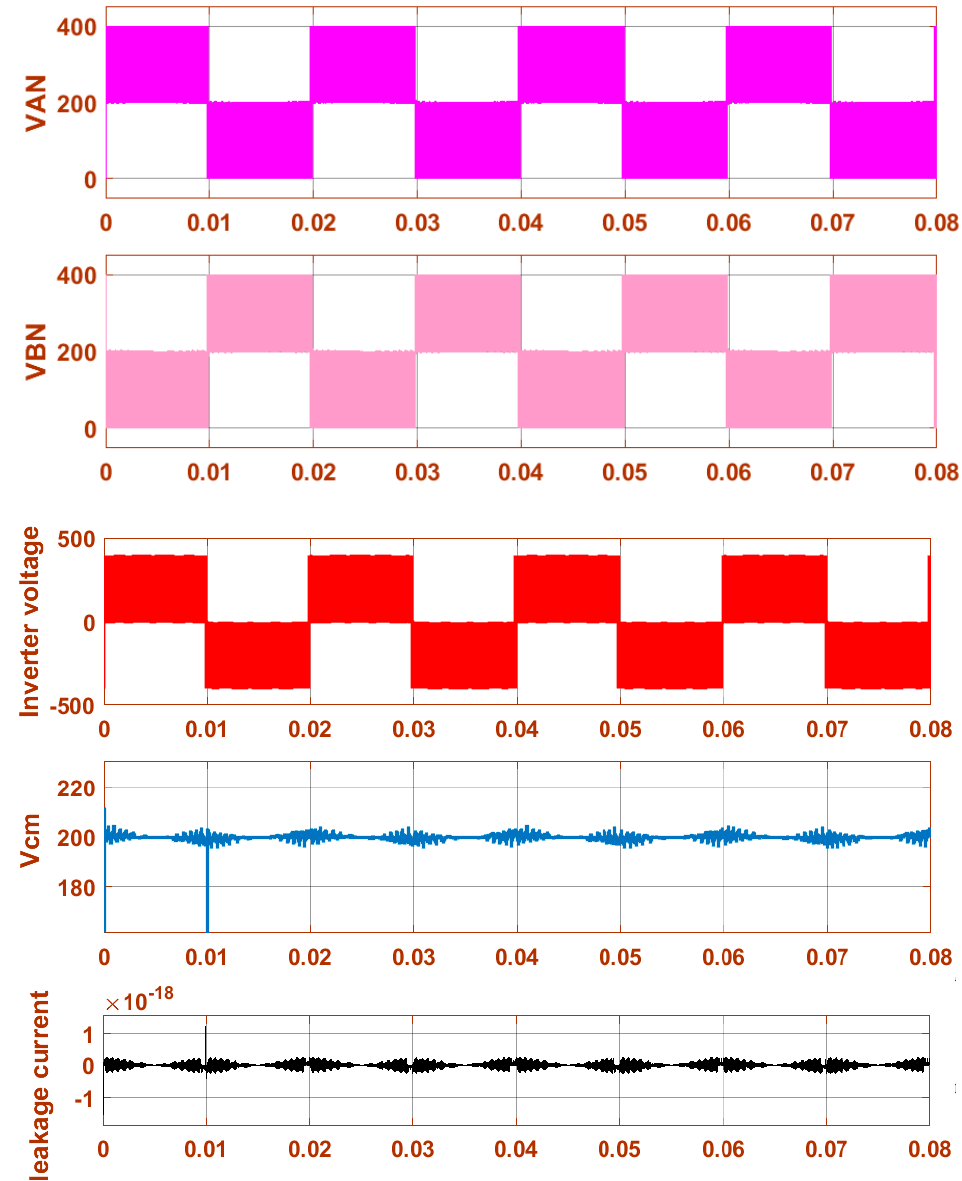
Figure 15. Waveform of V AN , V BN , inverter voltage and V cm , leakage current of H6 II inverter.